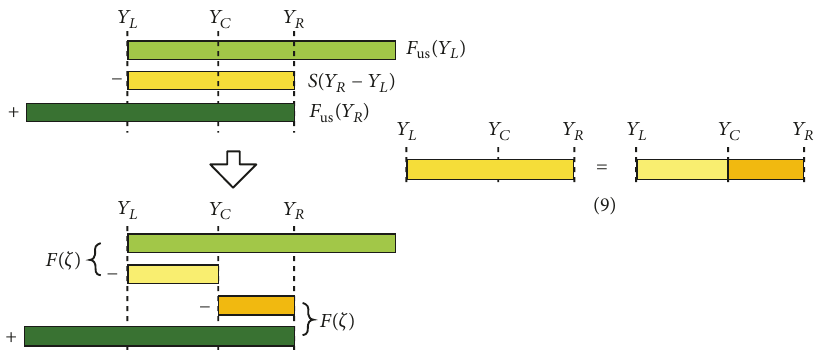
Figure 2: Rapidity subtractions and definition of right and left moving